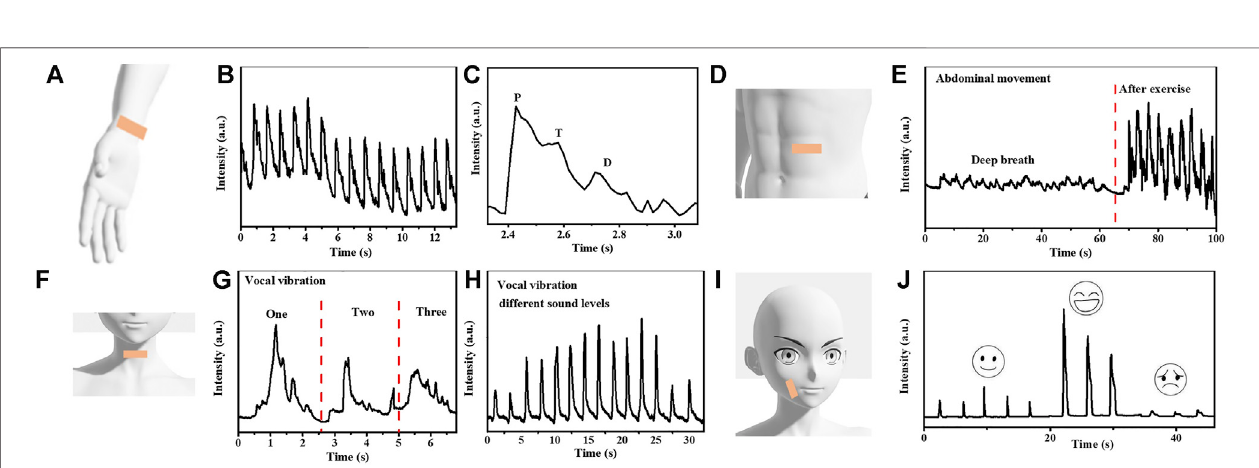
FIGURE 7 | Applications of the fl exible graphene strain sensor for detecting various subtle human motions: (A, D, F, and I) . Schematic illustrations of the sensor attached to different parts for detecting subtle human motions; (B) The electrical response induced by the wrist pulse; (C) Magni fi ed image of a single pulse, revealing typical characteristics of the pulse; (E) Detecting of the respiration rate with different breath modes; (G) Electrical response towards different words pronounced by the tester; (H) Electrical response towards different sound levels; (J) Electrical response of different facial expressions.